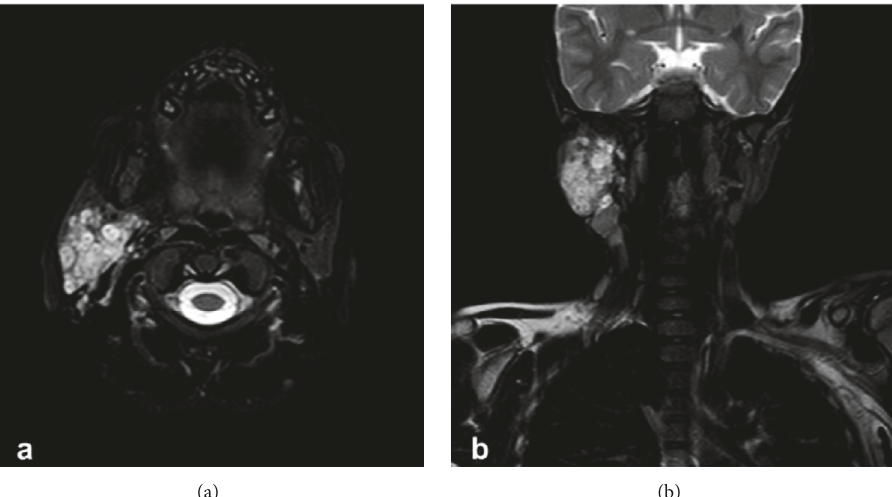
Figure 1: Axial (a) and coronal (b) fat suppressed T2-weighted MR images indicating a large, heterogeneous, lobulated, fusiform, and hyperintense mass in the right parotid region. The multinodular lesion exhibits a target-like appearance due to a peripheral zone of higher intensity. Note the enlarged jugular and spinal accessory lymph